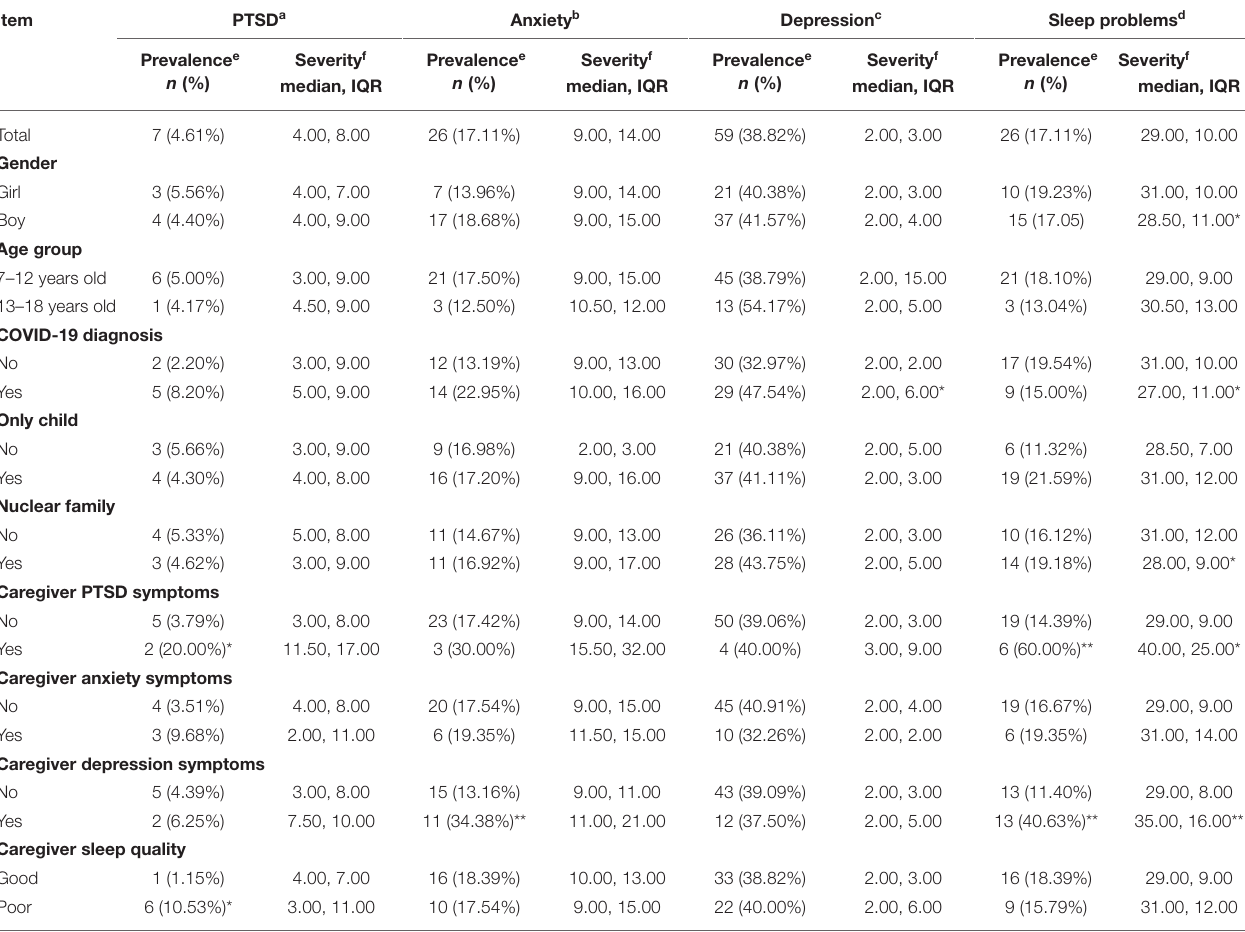
TABLE 2 | Prevalence and severity of psychiatric symptoms in children stratified by epidemiological characteristics ( n =